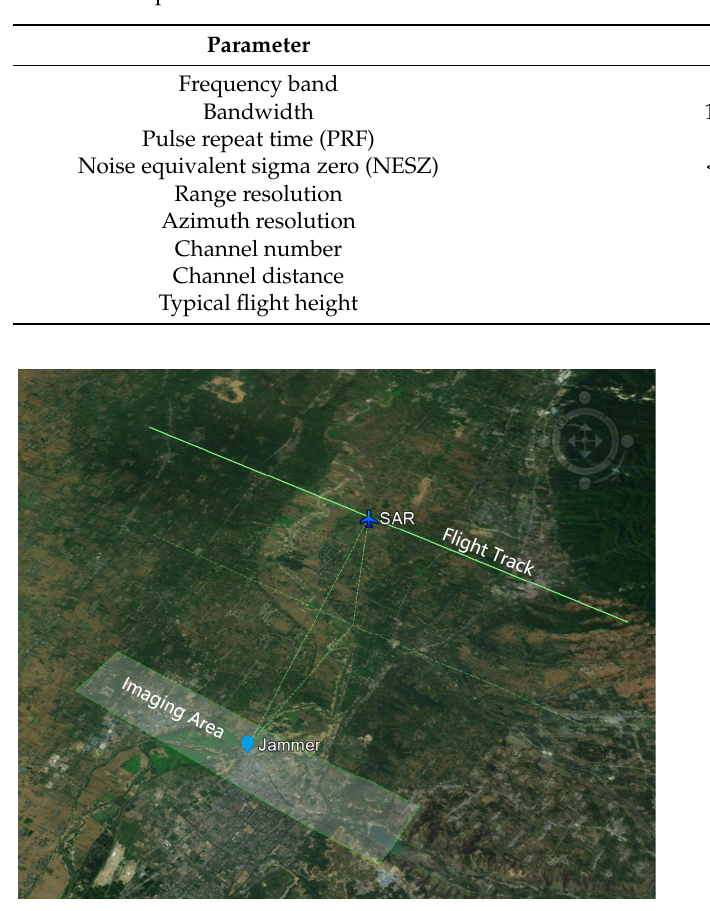
Figure 11. Geometric relationship of the SAR and the jammer.